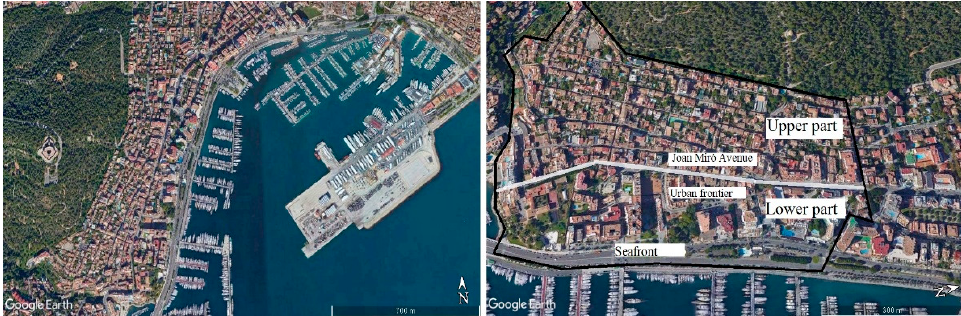
Figure 3. Aerial perspective and large urban areas of El Terreno. Source: Own elaboration from Google Earth (Lawrence, KS, USA) (2020).